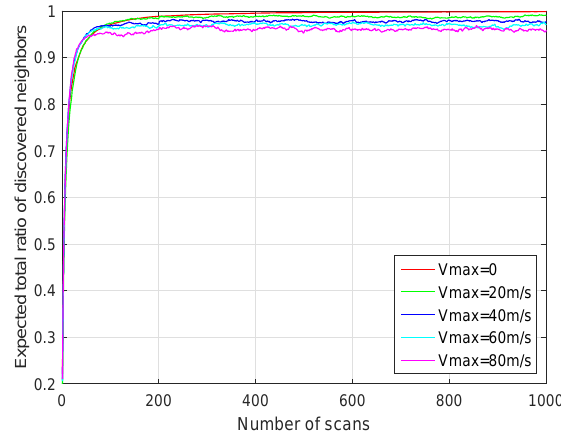
Figure 15. Performance with different moving